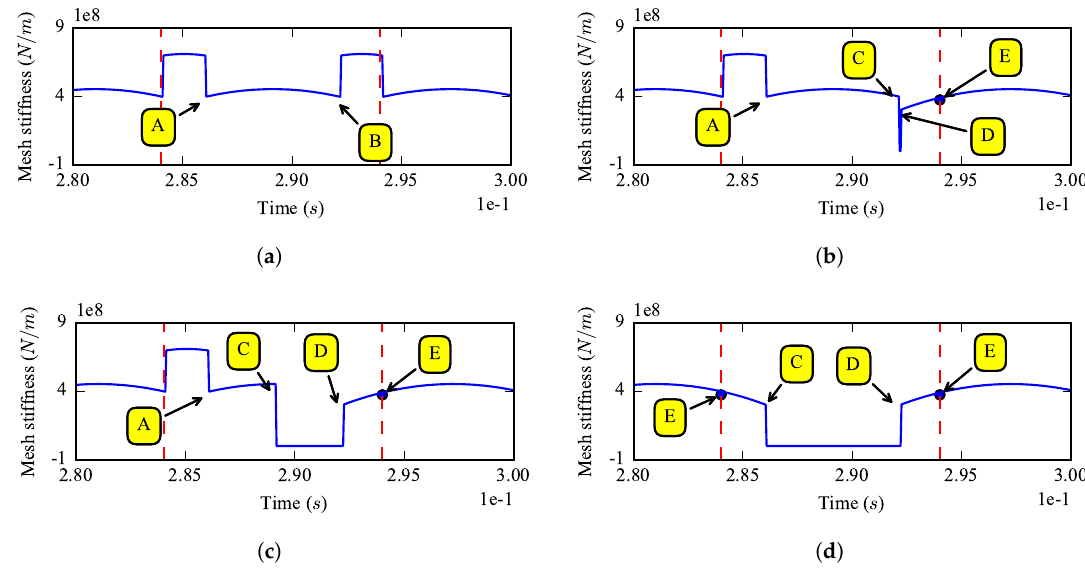
Figure 5. Partial enlarged views of the mesh stiffness with different breakage sizes: ( a ) p = 0, ( b ) p = 0.2, ( c ) p = 0.5 and ( d ) p =